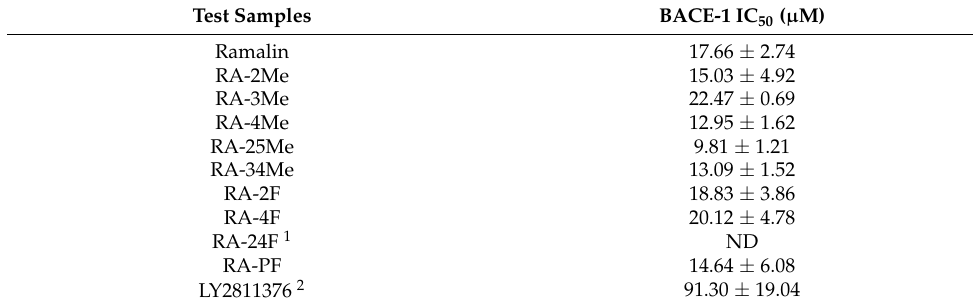
Table 2. In vitro inhibition of BACE-1 by ramalin and its